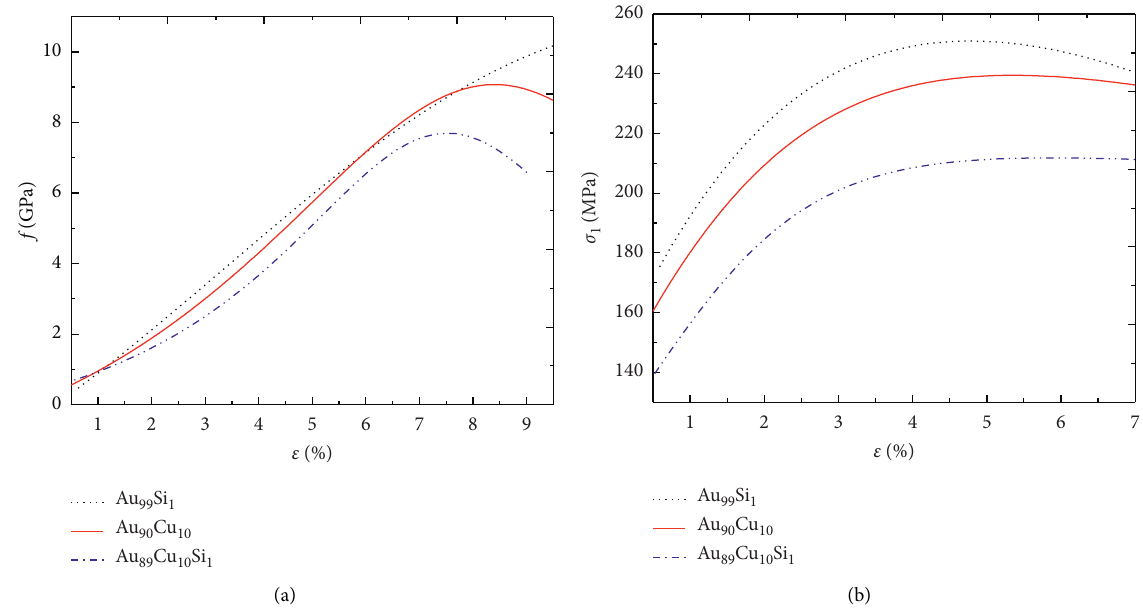
Figure 3: The density of deformation energy f ( ε ) (a) and the real stress σ P � 0 calculated by the SMM.